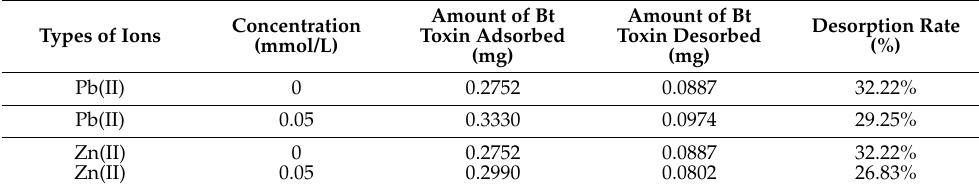
Table 2. Effect of lead and zinc ions on the desorption of Bt toxin in black